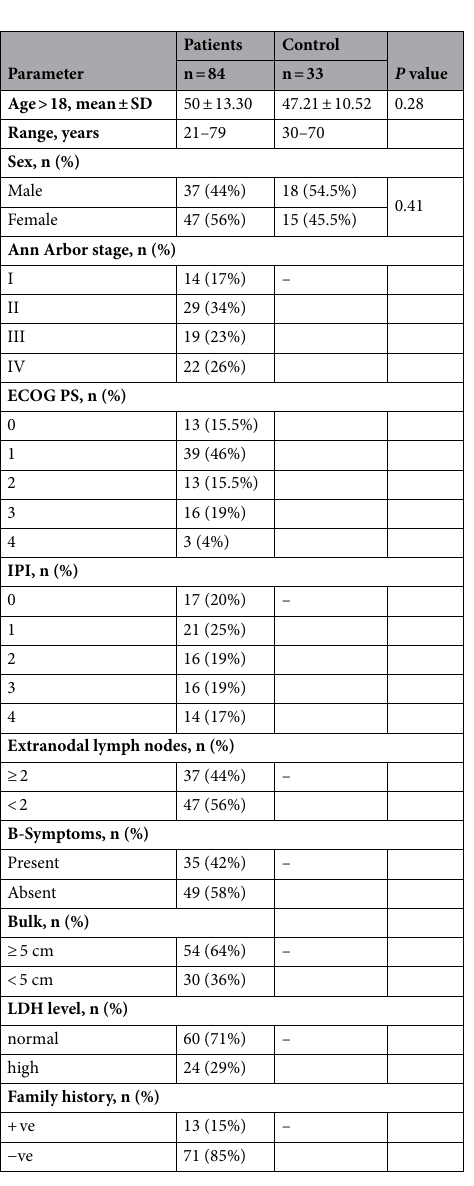
Table 1. Demographic and clinical characteristics of DLBCL patients and healthy controls. Data are expressed as mean ± SD or number (percentage). IPI International Prognostic Index, LDH lactate dehydrogenase, PS performance